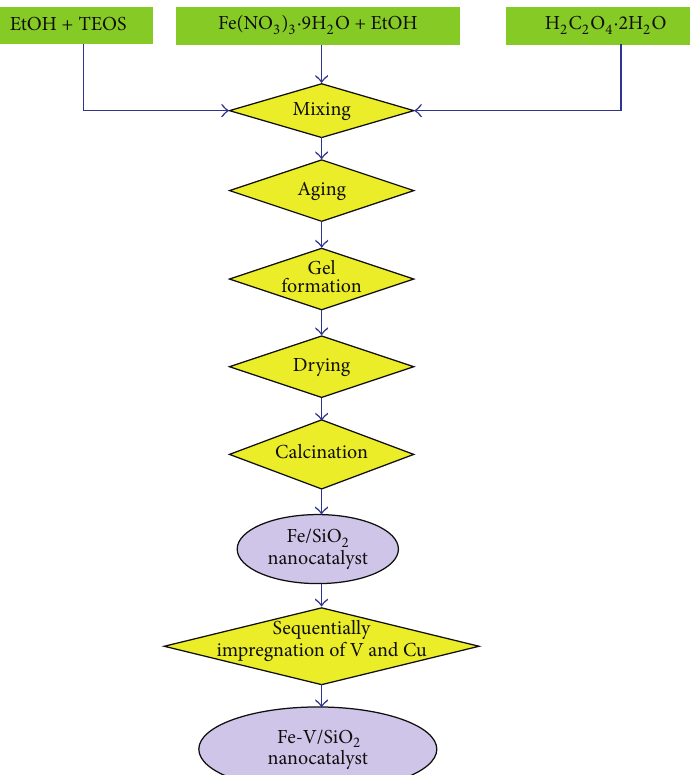
Figure 1: Diagram of the chemical process for the preparation of Fe-V/SiO 2 nanocatalyst.